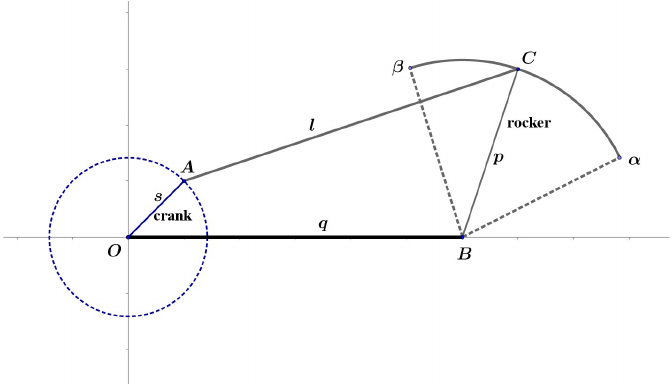
Figure 1. Crank-rocker linkage system.